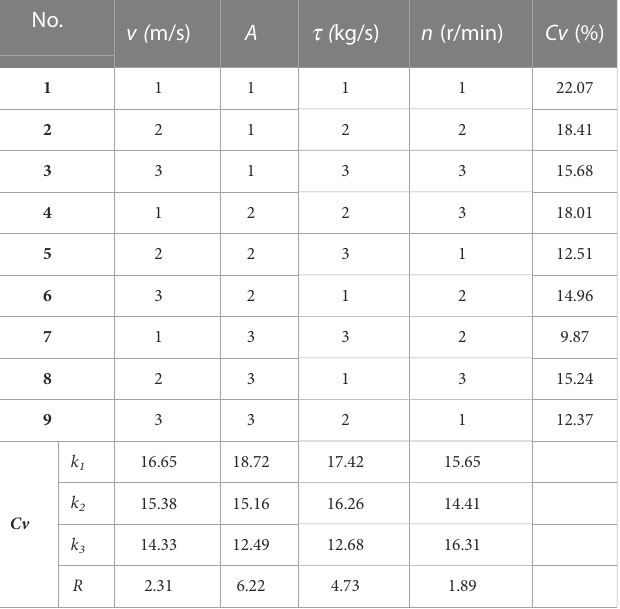
TABLE 11 Whole machine test scheme and results.